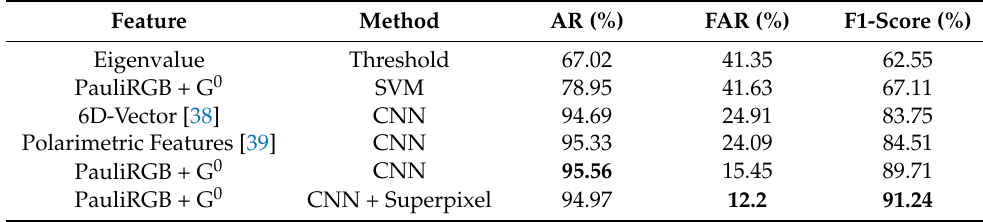
Table 2. Different methods of building extraction effects under GF-3